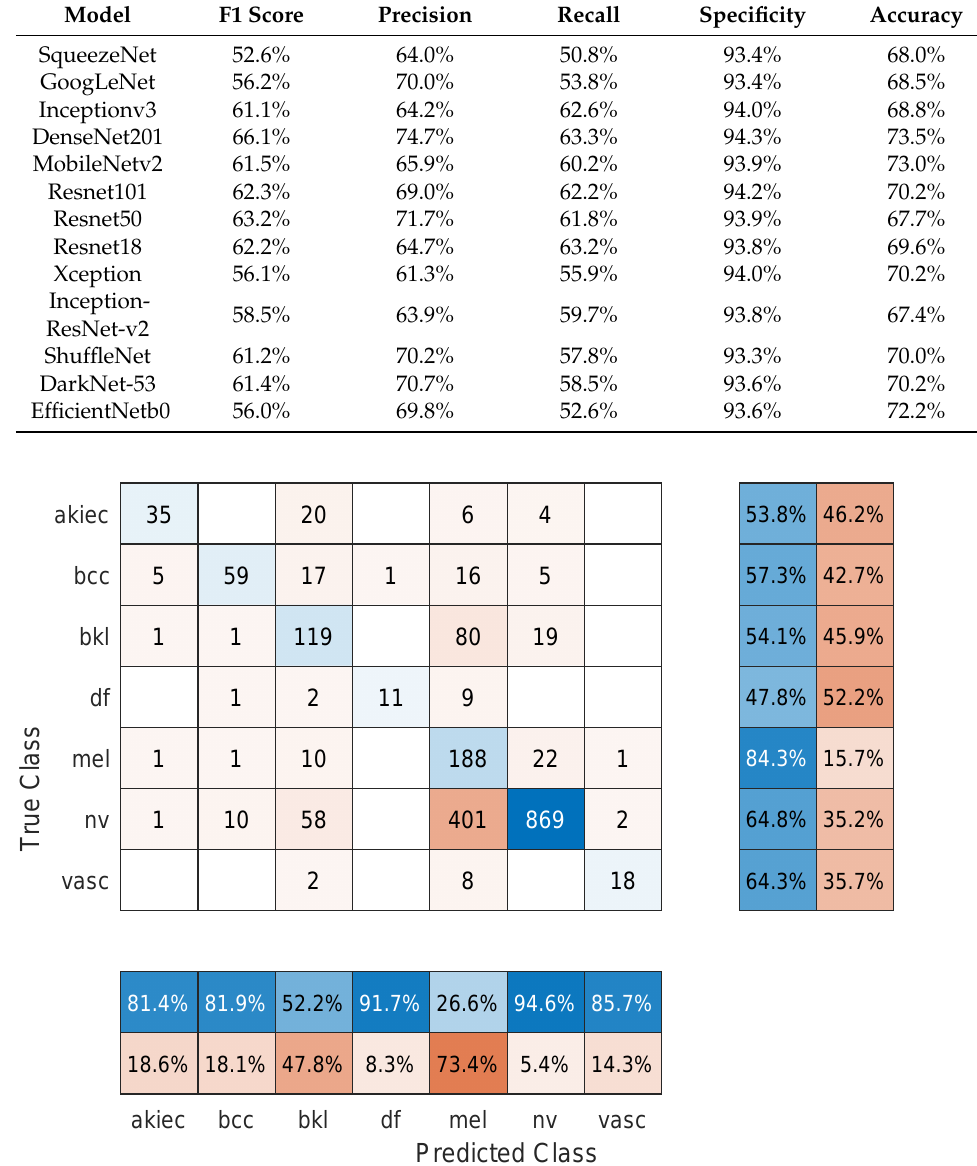
Table 2. The mean overall accuracy, F-score, precision, recall, and specificity for each deep learning model and an 80/20 data split.